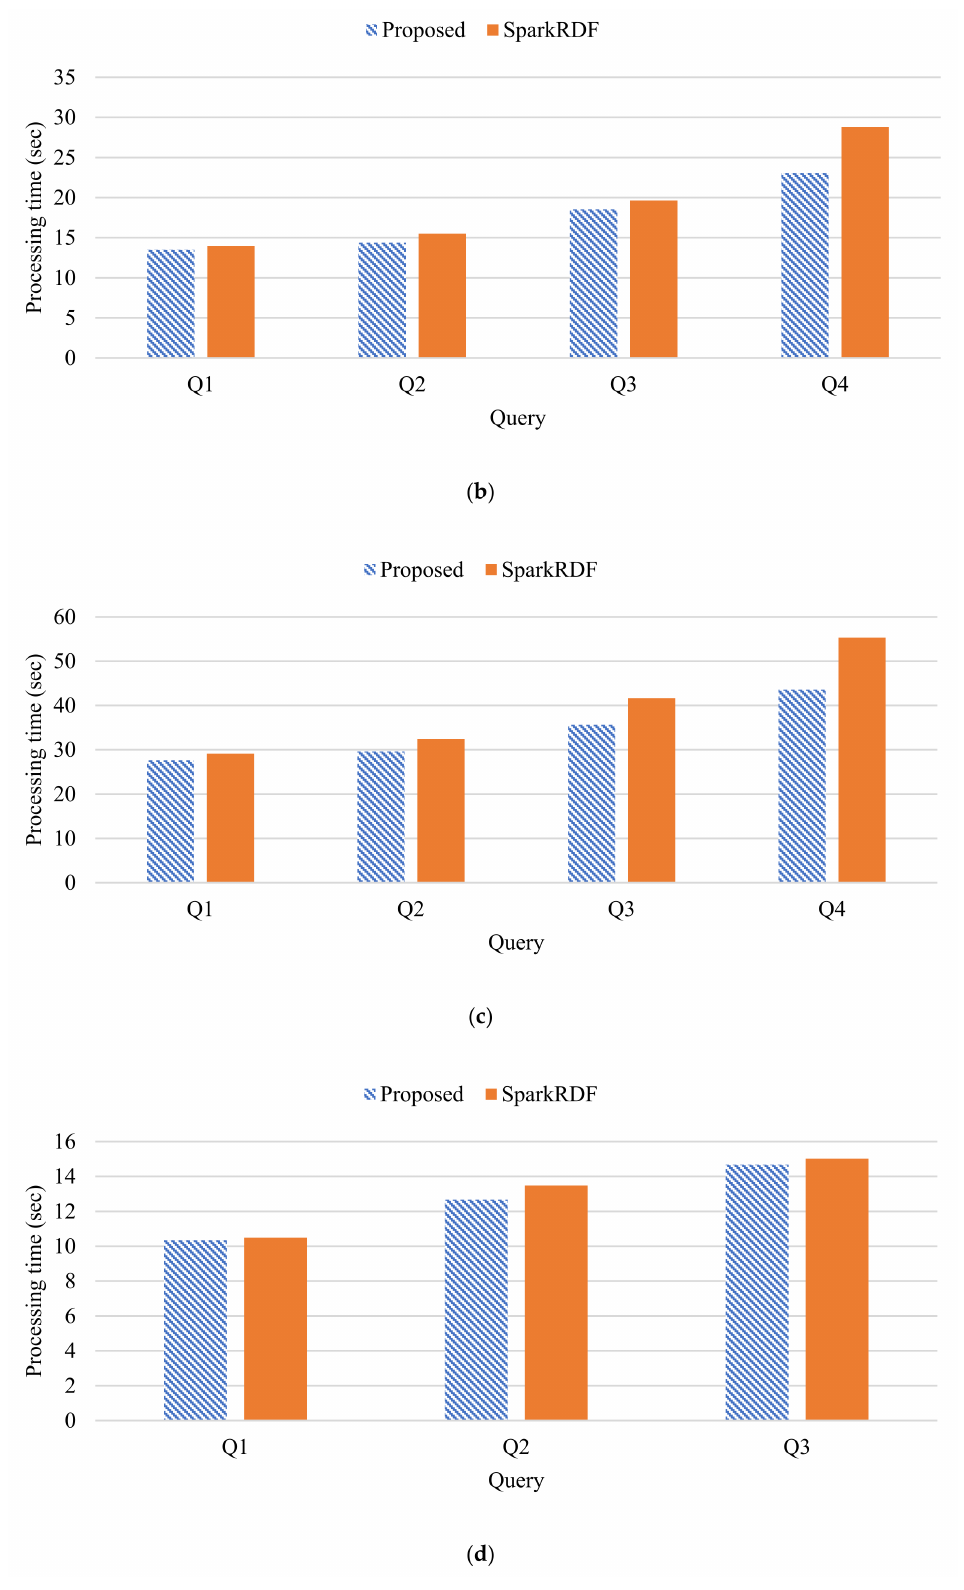
Figure 8. Query processing time: ( a ) LUBM 230,000 dataset; ( b ) LUBM 430,000 dataset; ( c ) LUBM 910,000 dataset; ( d ) DBpedia 300,000